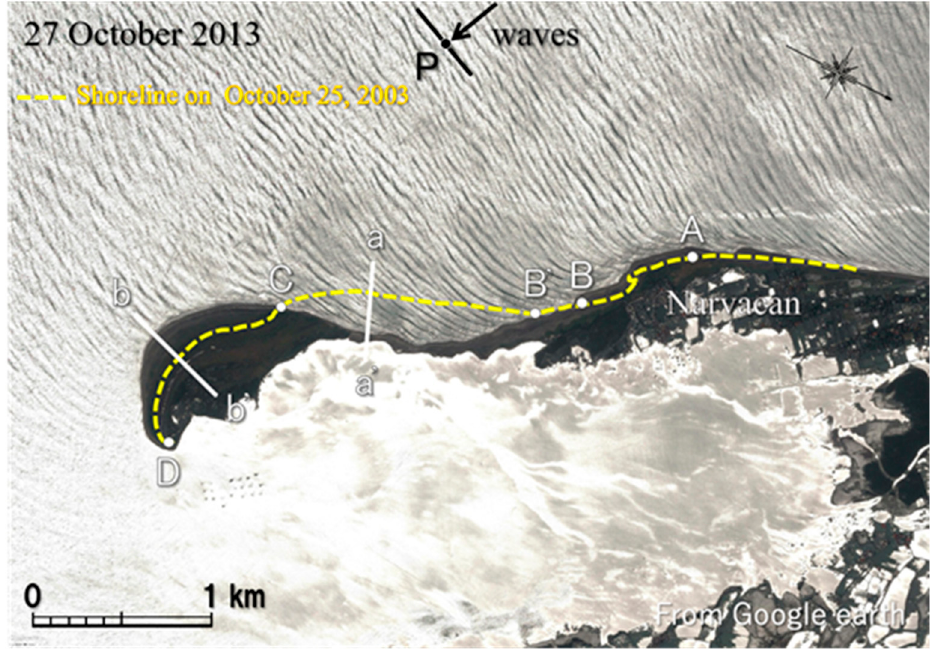
Figure 24. Satellite image around the sand spit at Santo Tomas (27 October 2013). By 28 February 2015, the shoreline retreated between B’ and C with a maximum shoreline recession of 210 m at transect a–a’, whereas the shoreline advanced between C and D with a maximum shoreline advance of 190 m at transect b–b’ (Figure 25). As men ‐